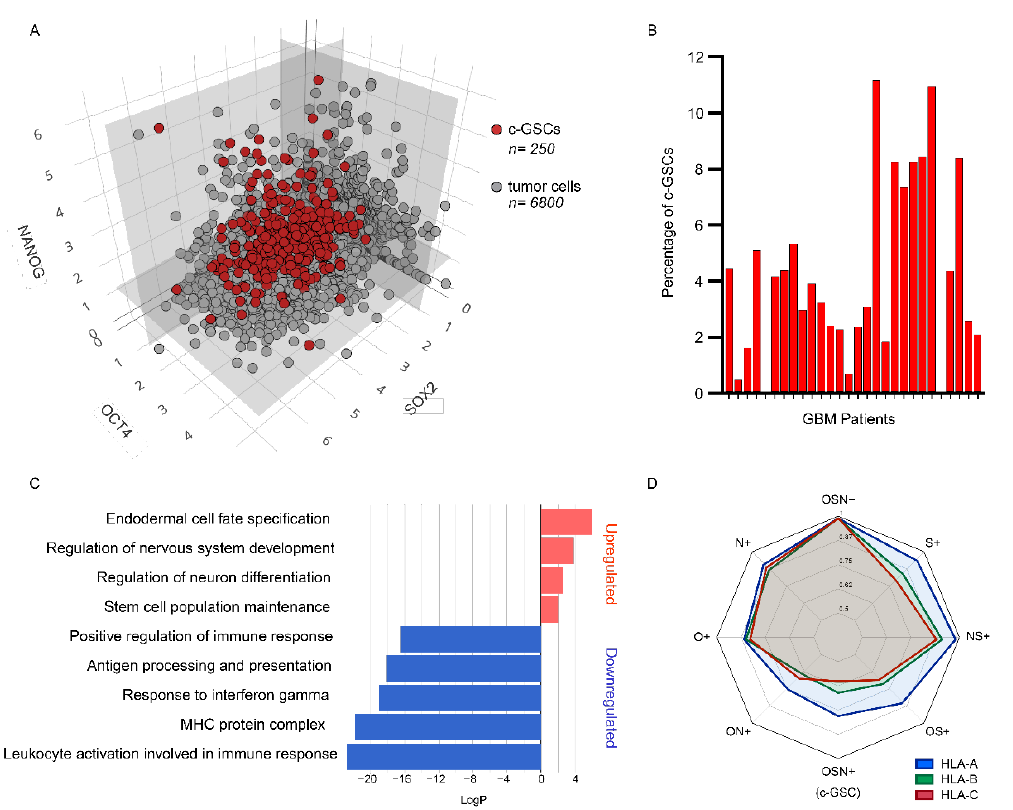
Figure 1. Core glioma stem cell population in glioblastoma samples. ( A ) Three-dimensional scatter plot of GBM single-cells ( n = 7930) from 28 patients based on the expression levels of OCT4 ( x -axis), NANOG ( y -axis), and SOX2 ( z -axis). Red dots represent c-GSCs co-expressing OCT4, SOX2, and NANOG ( n = 339). Gray dots represent the remaining cells from tumor bulk ( n = 7591). An interactive version of this data can be found: https://coregliomastemcells.github.io/Fig1a.html, accessed on 13 December 2021. ( B ) Bar plot showing the percentage of c-GSCs in each GBM patient. ( C ) GO analysis of biological pathways upregulated (red) and downregulated (blue) in c-GSCs. ( D ) Radar plot representing the expression levels of HLA-A, -B, and -C genes on different GBM single-cell populations based on the expression of OCT4, SOX2, and NANOG (OSN).